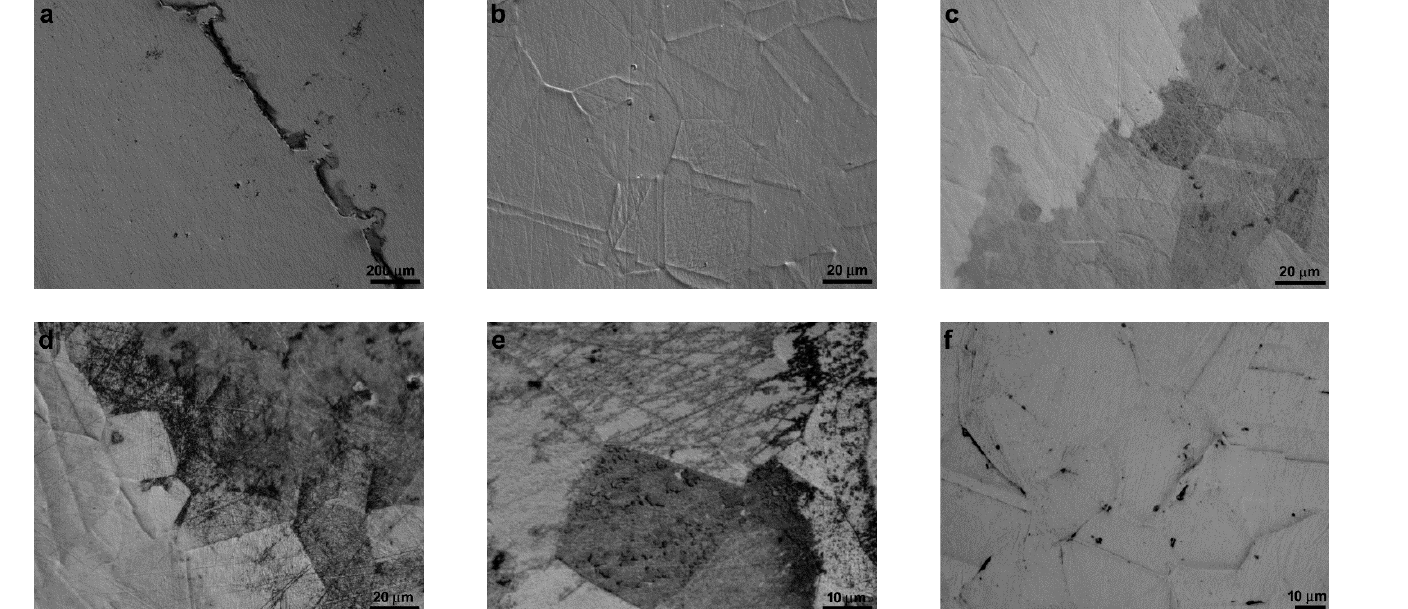
Figure 14. Micrographs of the surface morphology after the potentiodynamic tests of samples untreated ( a ), nitrided at 360 °C, 50 vol.% N 2 + 50 vol.% H 2 , for 1 ( b ) and 5 ( c ) h, and at 380 °C, 50 vol.% N 2 + 50 vol.% H 2 , for 3 h ( d – f ).